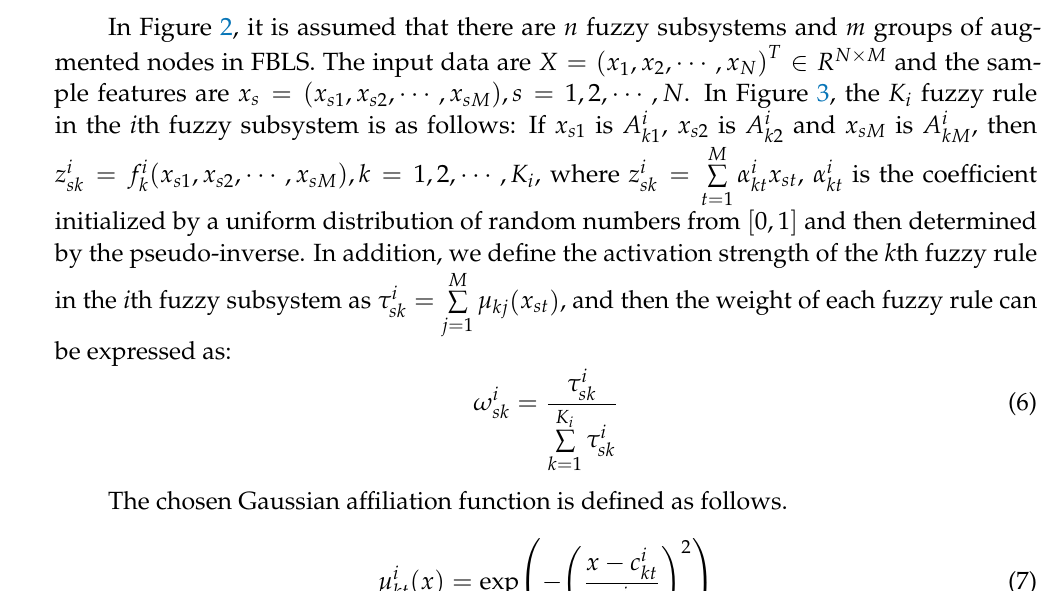
Figure 3. Fuzzy subsystem structure.